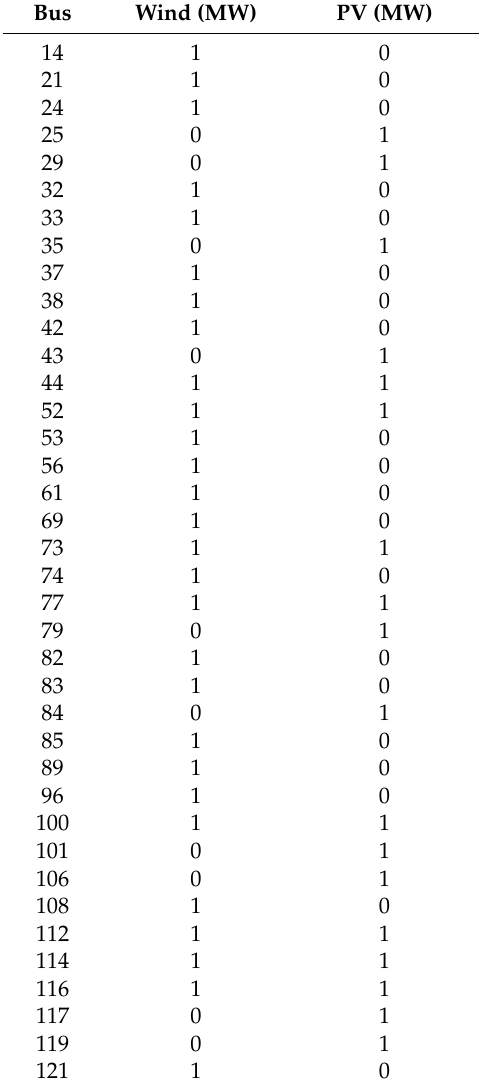
Table 2. The size and location of wind- and photovoltaic (PV)-type distributed generations (DGs).